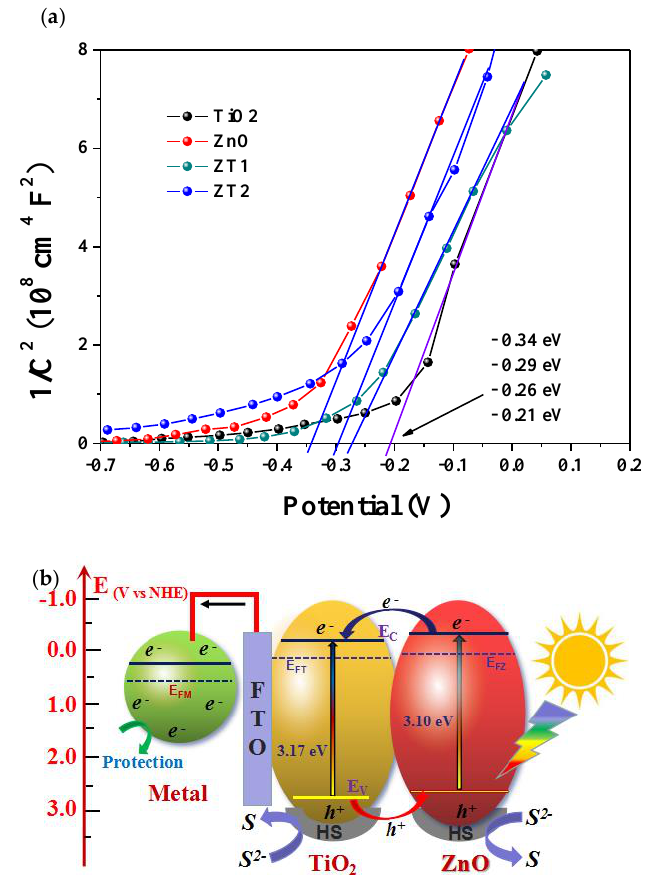
Figure 9. ( a ) Mott-Schottky plots of the photoanode films in 0.1 M Na 2 SO 4 solution in dark state. ( b ) Schematic illustration of the band alignment and the photogenerated electron-holes migration mechanism in the ZnO / TiO 2 heterojunction film under simulated solar light illumination for photocathodic protection.